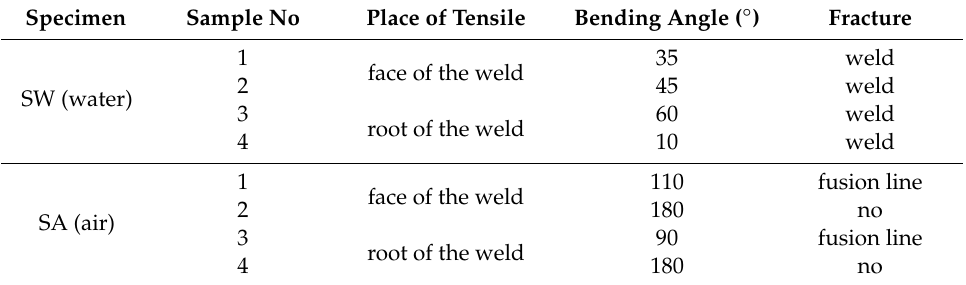
Table 5. Results of bending